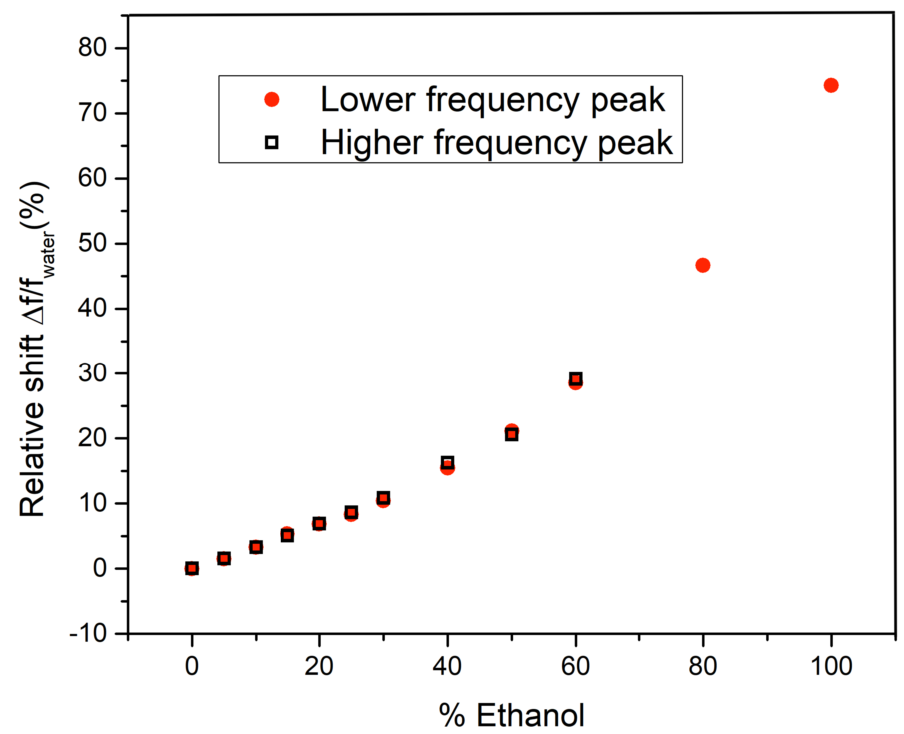
Figure 5. Relative frequency shift ∆ f/f water as a function of the ethanol percentage for the lower (red circle) and higher frequency (empty black square) peaks visible in Figure 4.